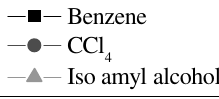
Figure 5. Variation of acoustic impedance (Z), with mole fraction for all the systems